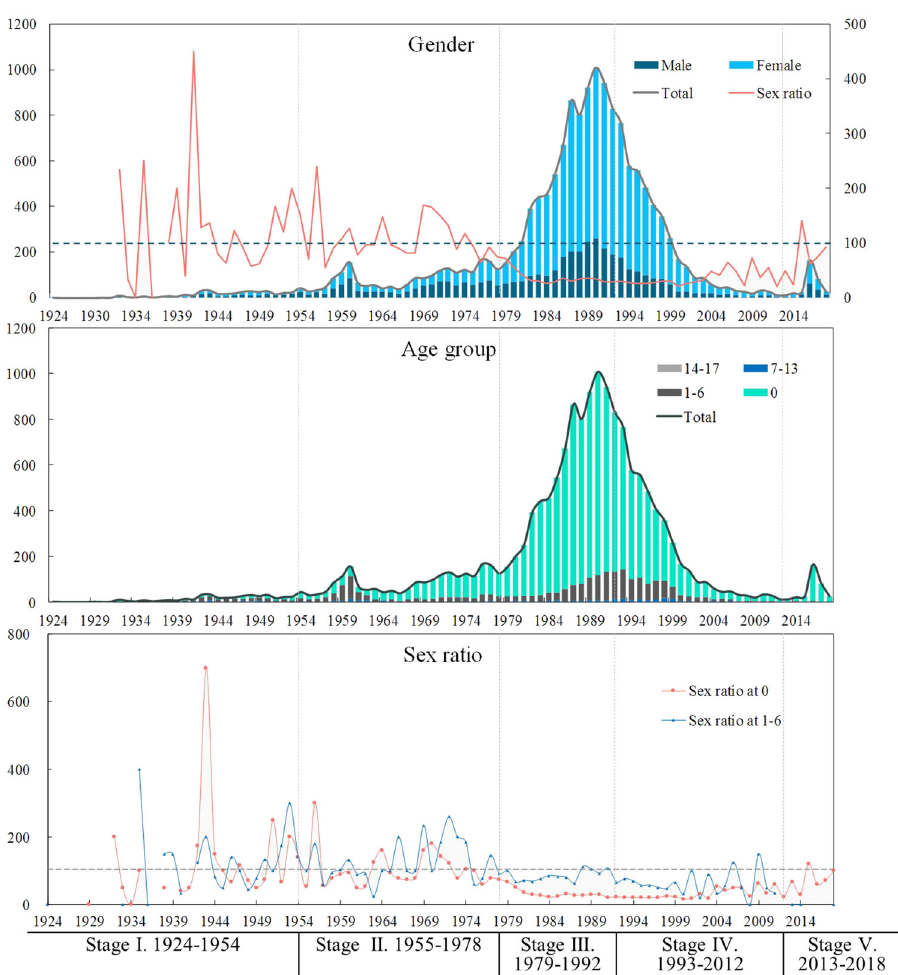
Fig. 2 Time evolution process of informal adoption. According to the curve pattern and major events and certain circumstances in China, 1924 – 2018 was divided into six